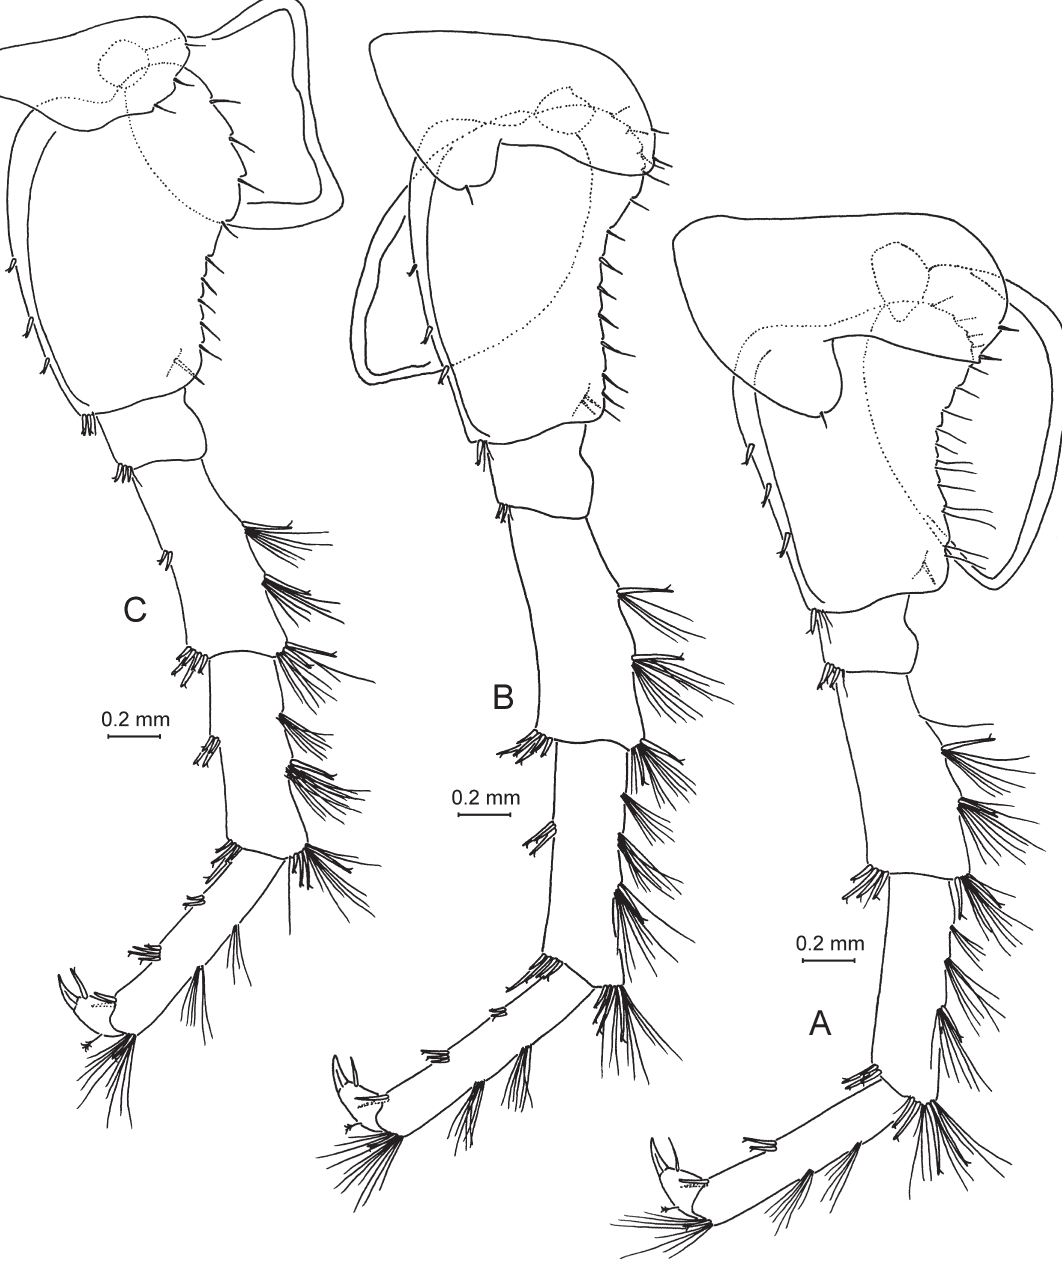
Fig. 10. Zenkevitchia sandroruffoi sp. nov. Holotype, ♂, 8.0 mm, X44041/Cr-1647-FEFU. A . Pereopod 5. B . Pereopod 6. C . Pereopod